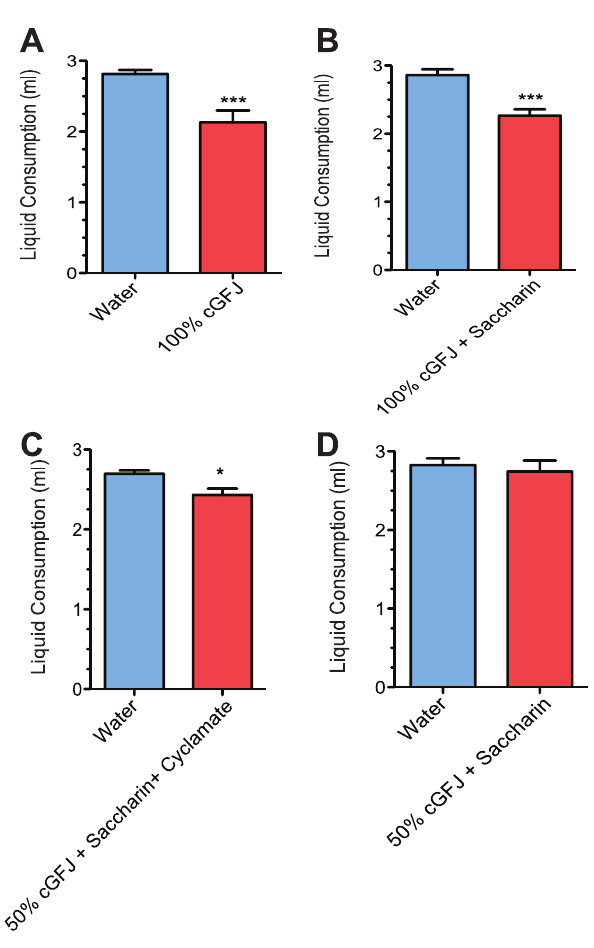
Figure 1. Effects of cGFJ/sweetener on liquid consumption. Mice were given 100% cGFJ, 100% cGFJ + 0.15% saccharin, 50% cGFJ